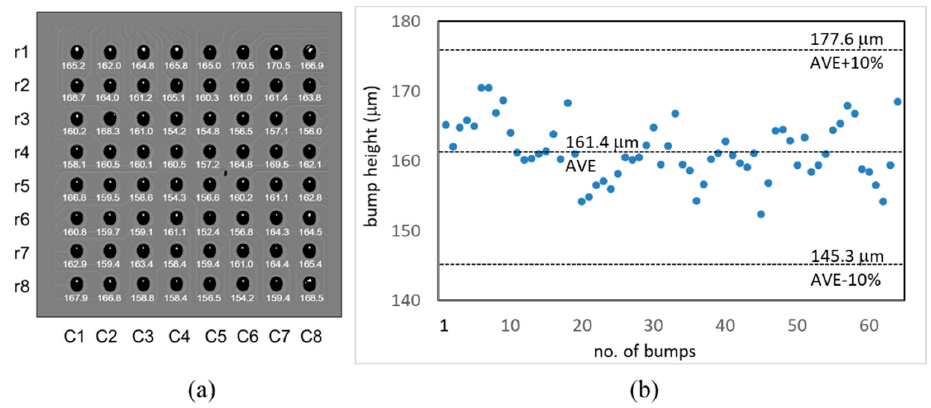
Figure 14. ( a ) Unwrapped phase map of the 8 × 8 bump array for the polymer structure and the bump height map when corrected by PI for the oxide thickness influence. ( b ) Corrected bump height map with average of 161.4 μ m and coplanarity of 5.5%.